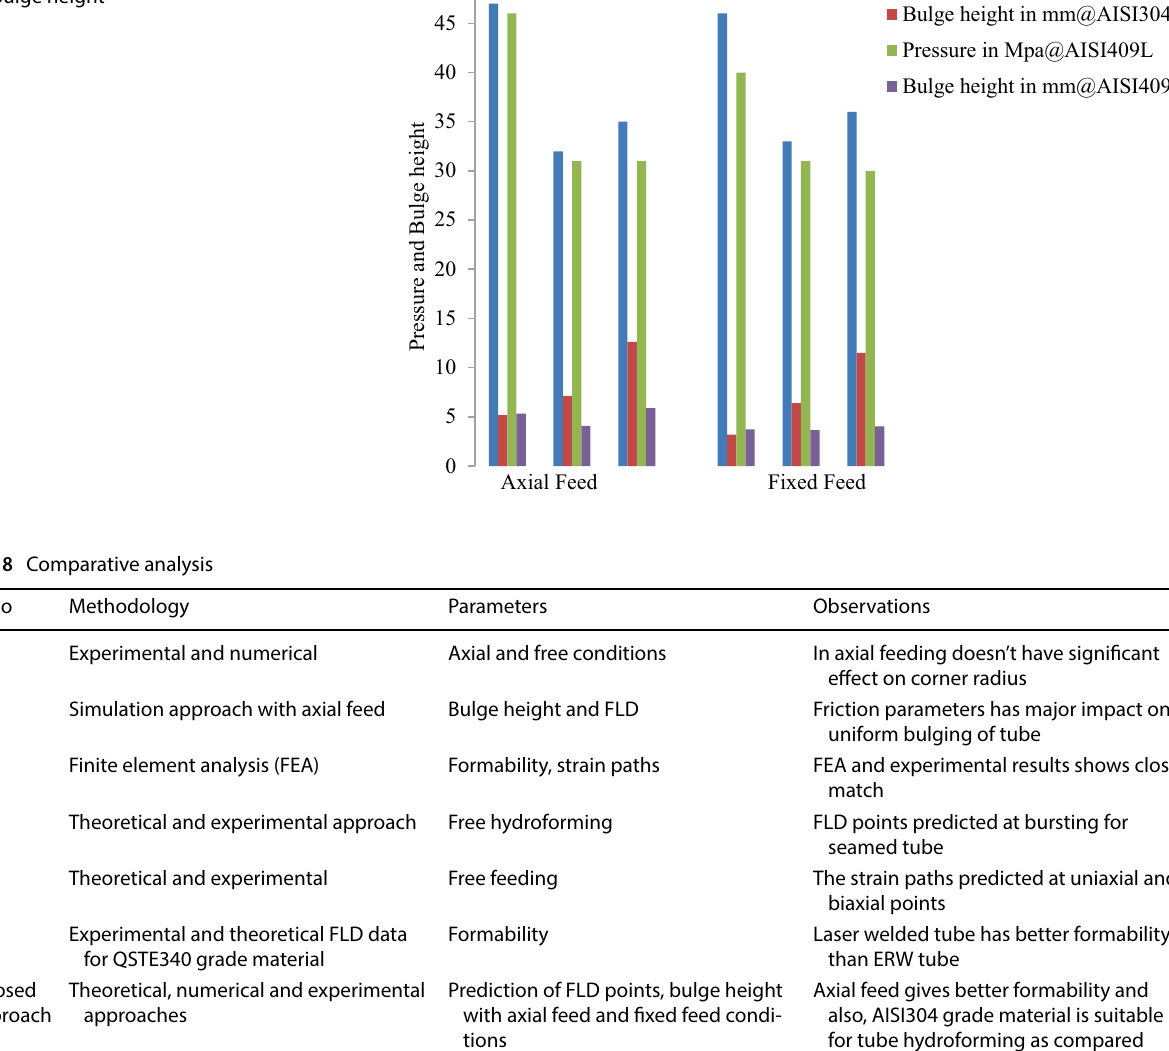
Fig. 16 Feed versus pressure and bulge height